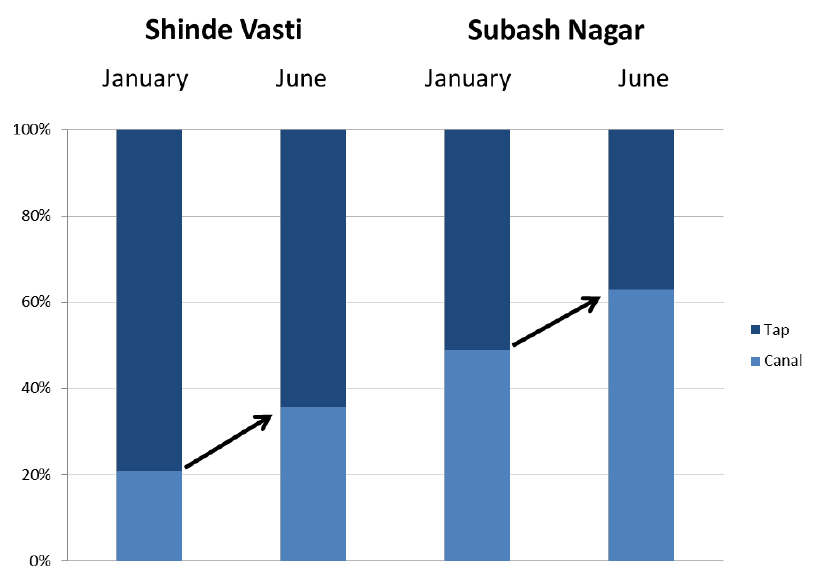
Figure 4. Seasonal variations in selection of water sources. The bar plots indicate the share of the two water sources tap and canal water in the overall water consumption of households across seasons (Data source: [41]). (Data source: